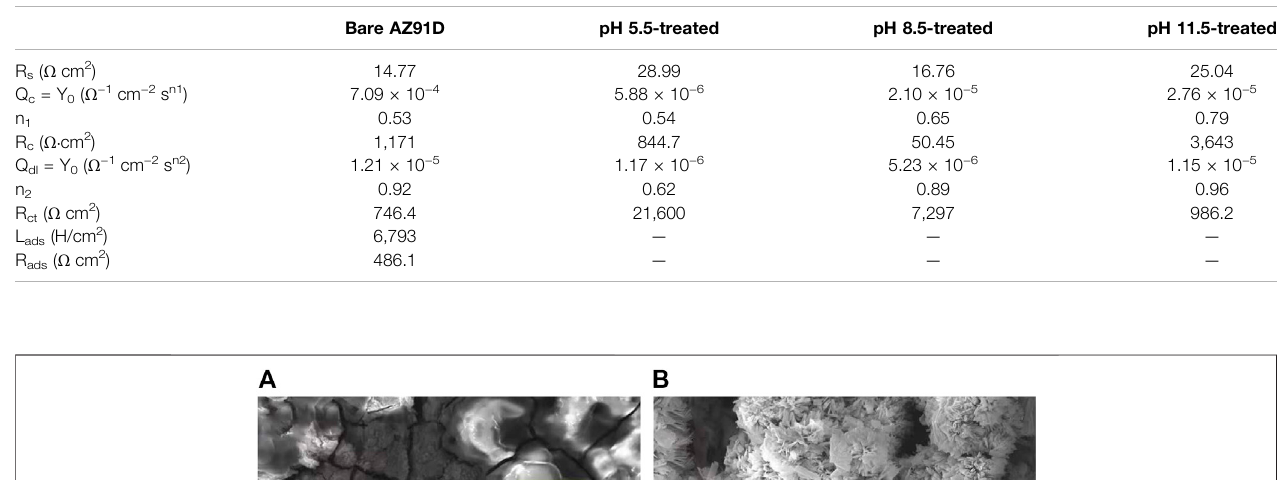
TABLE 3 | The fi tted values of EIS plots for Figure 7 .